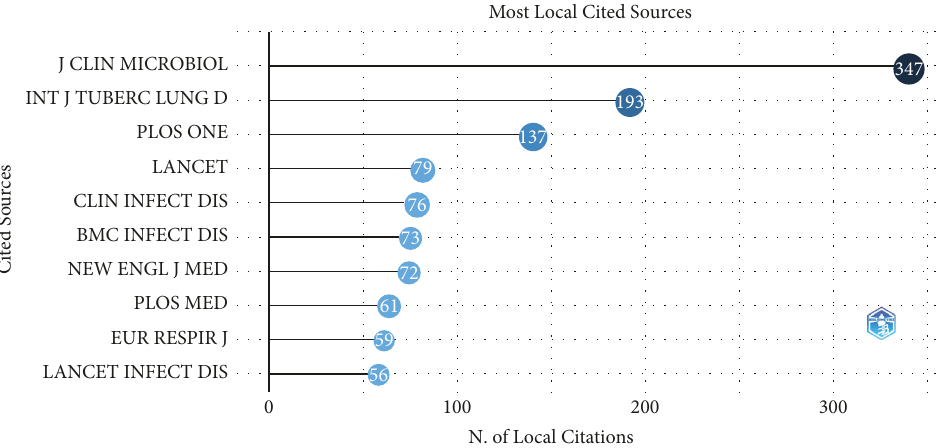
Figure 3: Top 10 cited journals on the GeneXpert in tuberculosis.